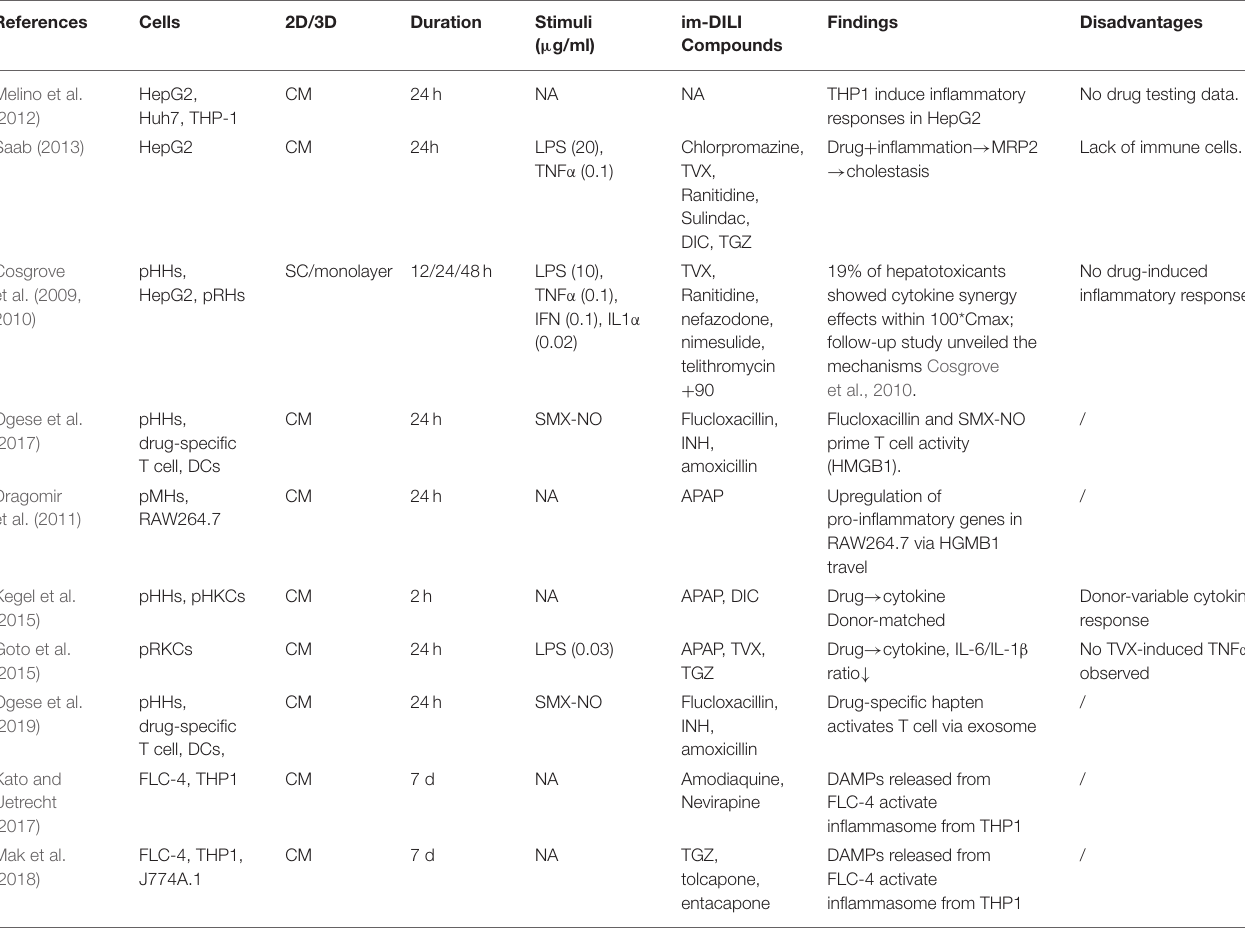
TABLE 1 | In vitro models comprising of soluble factors from conditioned media of hepatocytes and immune